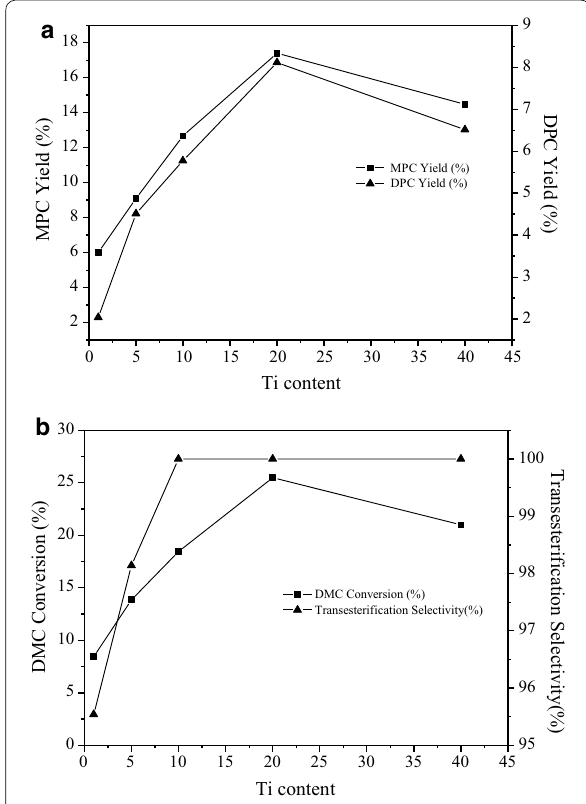
Fig. 8 a Influence of Ti content on the catalytic activity. b Influence of Ti content on the catalytic